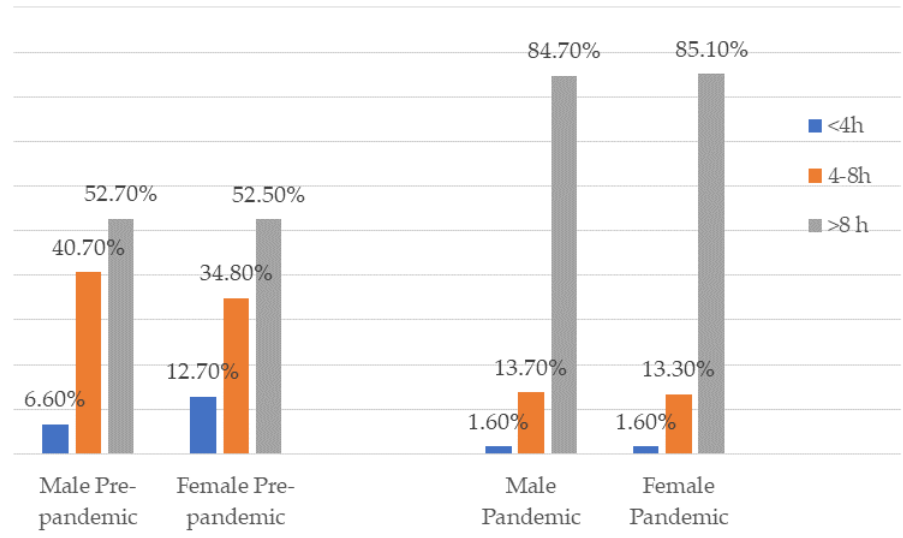
Figure 2. The number of hours spent in front of the computer/driving a car/watching TV.